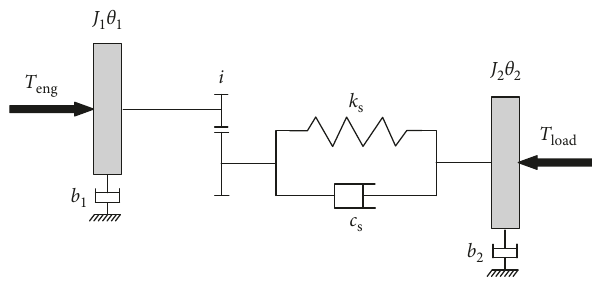
Figure 2: Two-dof control-oriented vehicle model.